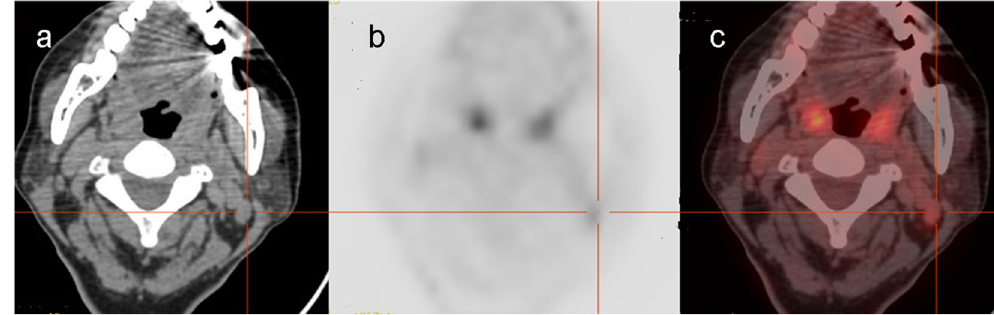
Figure 2. A false-positive lesion on the left neck region was revealed by 18 F-FDG PET/CT. A 62-year-old woman underwent total thyroidectomy with radical left neck dissection for PTC followed by radioiodine therapy with 3.7 GBq of 131 I. Three days later, post-therapy 131 I WBS was performed and showed negative results. Six months after ablation. The serum Tg level was 0.18 ng/mL and TgAb level was 46 IU/mL at TSH suppression status. TgAb level was stable for 4.2 yr after 131 I therapy. But subsequently, TgAb gradually increased at TSH suppression status. TgAb level elevated from 51 IU/mL to 137 IU/mL in the next follow-up of 2.2 years. 18 F-FDG PET/CT demonstrated increased foci radiotracer uptake in the left submandibular region ( a , b , crossing line), which was localized by CT image to the left submandibular lymph nodes with SUV max of 2.6 ( c , crossing line). However, infectious lymph node was diagnosed on histopathology after